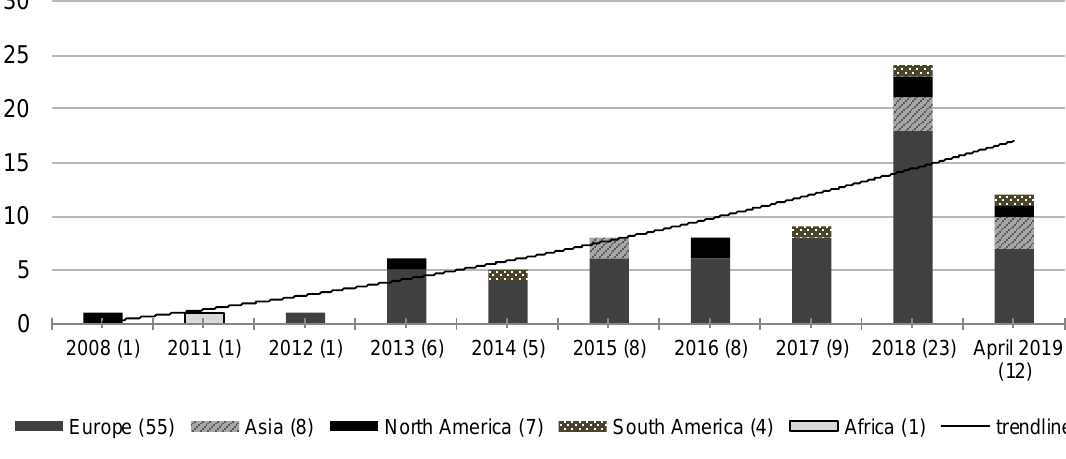
Figure 2. Numbers and geographical distribution of case studies in the articles published between 2008 and April 2019. The figures in brackets beside each year are the total number of articles published in that year; the total numbers of articles from each continent are also indicated. A polynomial trend line illustrates a predicted increase of the number of articles. (Note: One study is excluded due to its analysis of a fictional urban model).